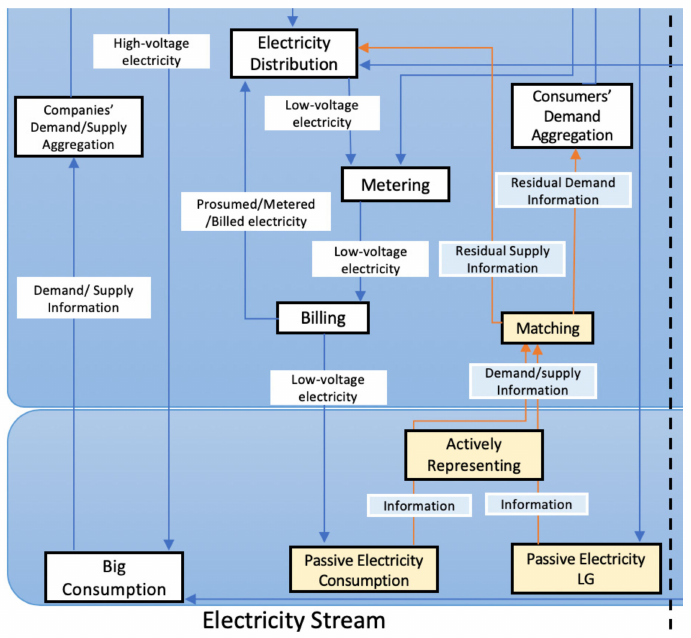
Figure 8. New activities and deliverables in the future electricity market. Reproduced from [10], Institute of Electrical and Electronics Engineers (IEEE): 2020.